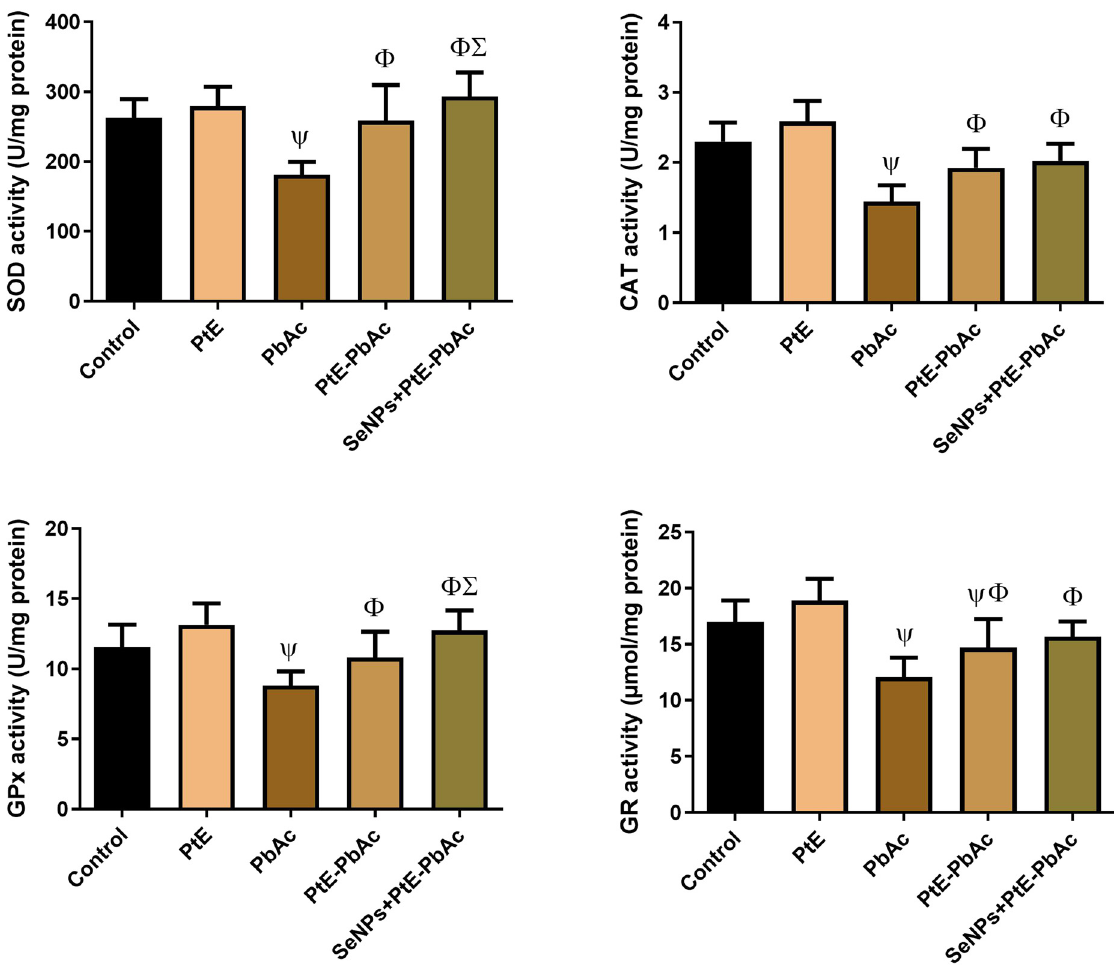
Figure 3: E ff ects of orally administered PtE or PtE - SeNPs on the antioxidant enzymatic activities of SOD, CAT, GR, and GPx in the brain of PbAc - injected rats. ψ , Φ , Σ superscript letters indicate statistical signi fi cance at P < 0.05 against control, PbAc, and PtE - PbAc group, respectively. All results are presented as the mean +